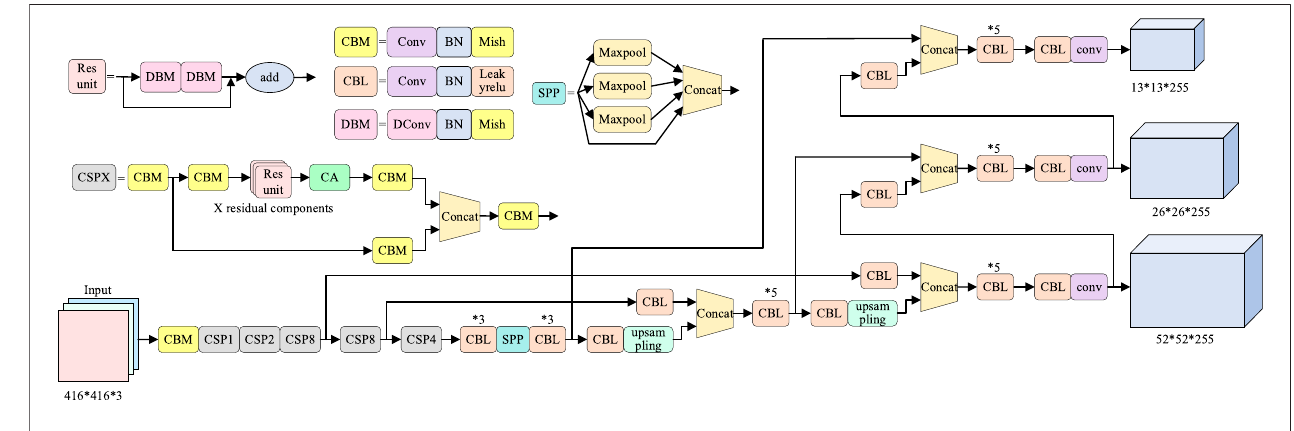
FIGURE 1 | Network structure of the improved YOLOv4